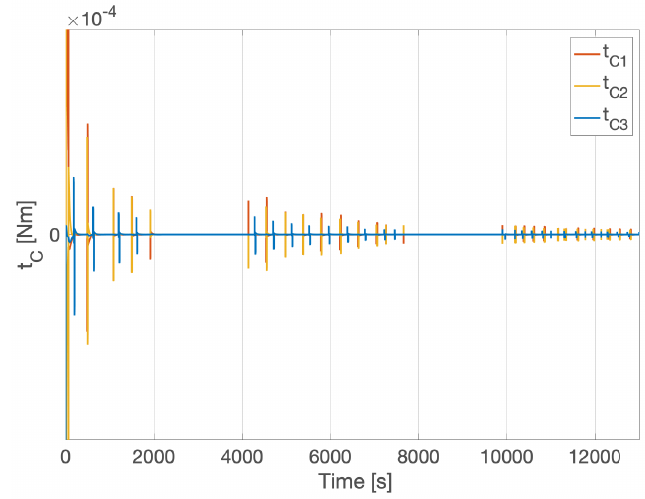
Figure 6. Control torques, with